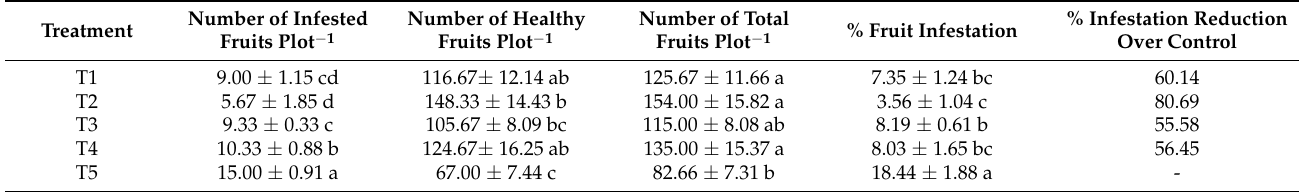
Table 3. Effect of different insecticides on OSFB in fruits of okra plants. Number of Healthy Number of Infested Treatment Fruits Plot − 1 Fruits Plot − 1